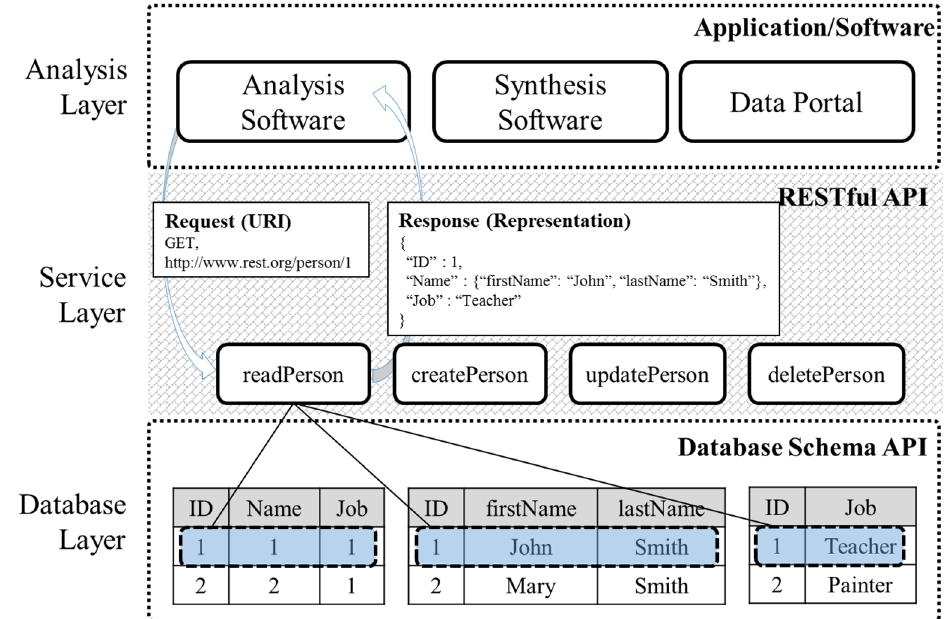
Figure 3. Web architecture for RESTful web services.